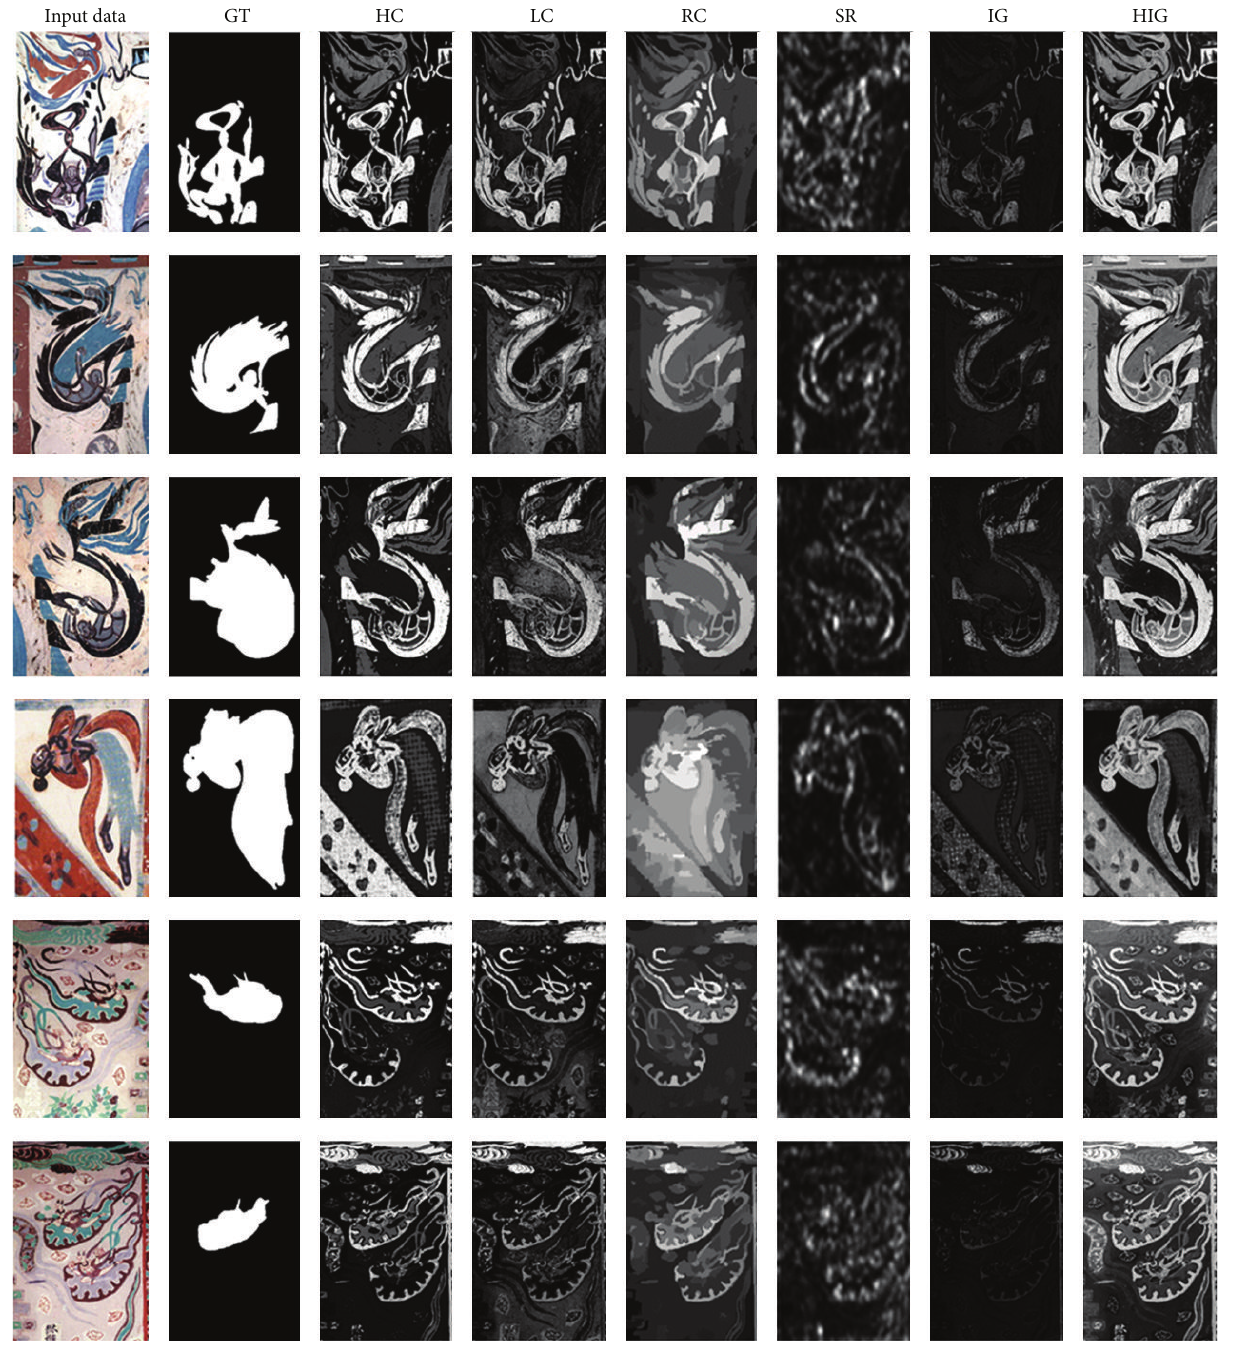
Figure 3: Comparison of visual detection results via different algorithms: HC [17], LC [11], RC [17], SR [12], IG [14], and HIG. And all these algorithms are compared based on the visual saliency ground